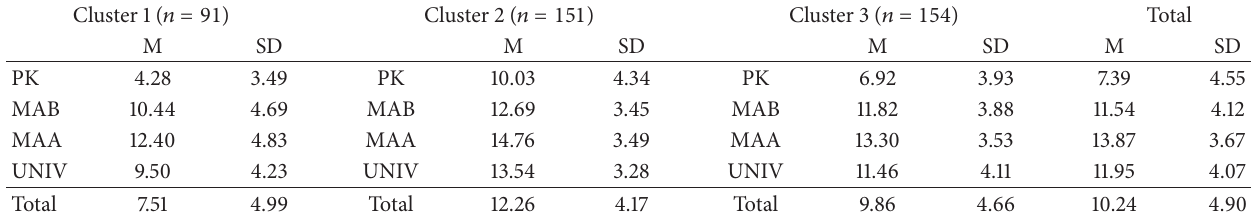
Table 5: Means and standard deviations for the mathematics performance in the motivation clusters and education level groups ( 𝑁 = 386). Cluster 1 ( 𝑛 = 91 ) Cluster 2 ( 𝑛 = 151 ) Cluster 3 ( 𝑛 = 154 ) M